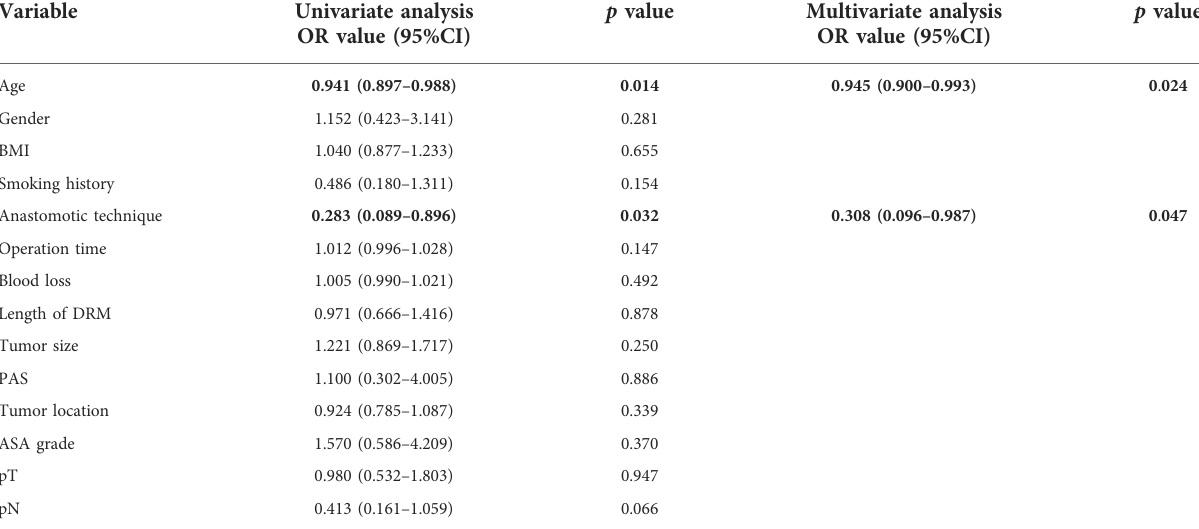
TABLE 3 Factors associated with anastomotic leakage.